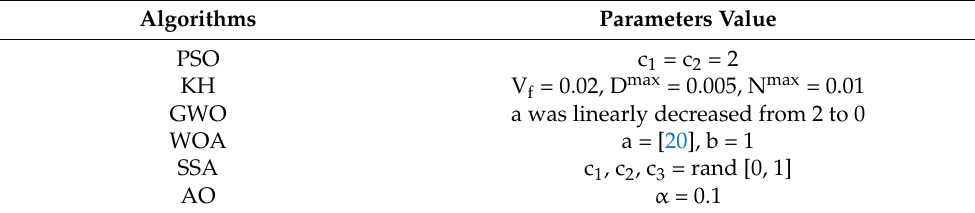
Table 1. Parameter settings.